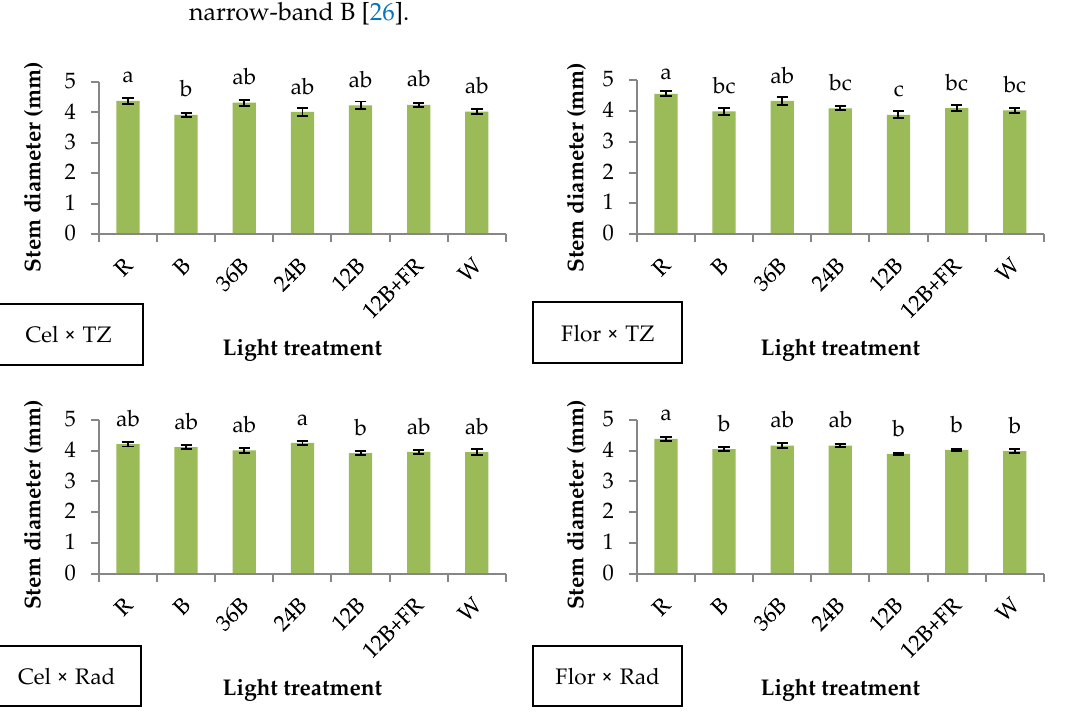
Figure 1. Stem diameter of grafted watermelon seedlings derived from four watermelon × interspecific squash genotype combinations, and after illumination by seven light treatments during healing. Bars ( ± SE) followed by different letters are significantly different ( p ≤ 0.05) Table 2. Shoot length, root/shoot (R/S) ratio, relative chlorophyll (chl) content, shoot dry weight/length (DW/L) ratio, and Dickson’s quality index (DQI) of grafted watermelon seedlings derived from four watermelon × interspecific squash genotype combinations, and after illumination by seven light treatments during healing. Mean values ( ± SE) within a scion × rootstock genotype combination followed by different letters are significantly different ( p ≤